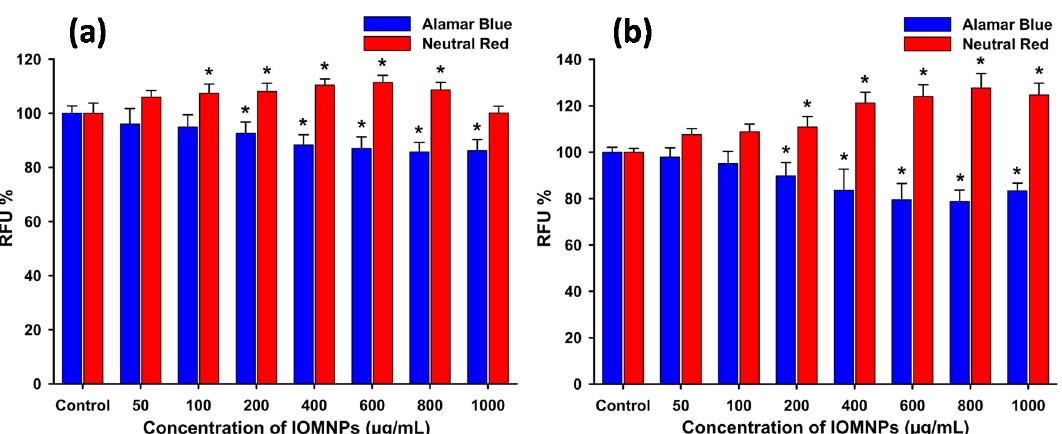
Figure 5. Cytocompatibility of magnetite nanoparticles (IOMNPs) on ( a ) Human Gingival Fibroblast (HGF) and ( b ) human cancer pulmonary (A549) cell lines, evaluated after 24 h exposure. Cellular viability was measured using two complementary assays, namely Alamar Blue and Neutral Red. The values are expressed as mean ± SD of six biological replicates. Data are expressed as relative values to the negative control. Asterisks (*) indicate significant differences compared to the negative control (ANOVA + Dunn’s; P < 0.05).